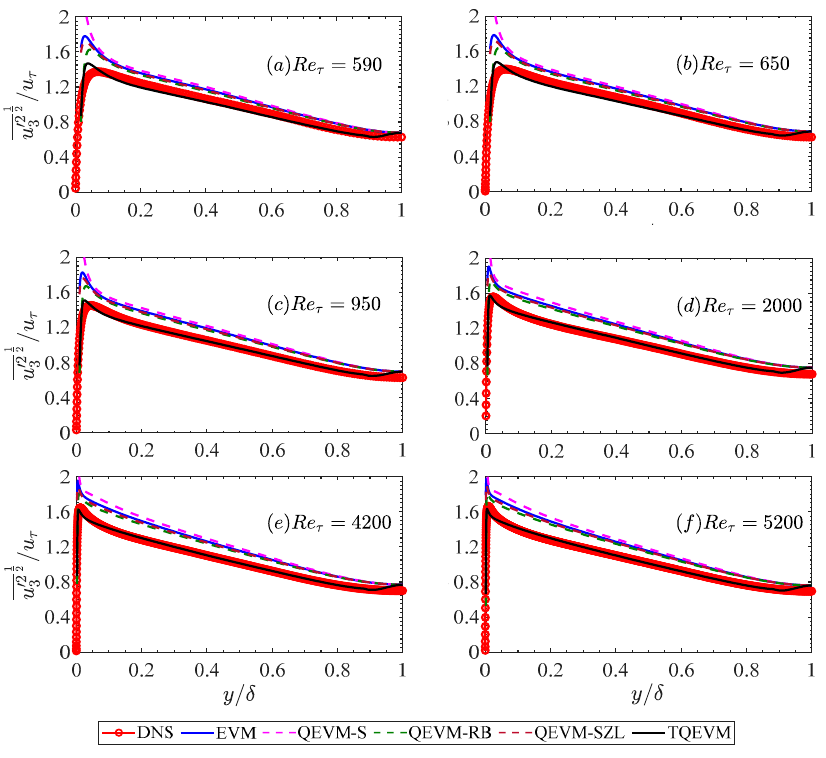
31/2 / u τ as a function of dimensionless wall distance